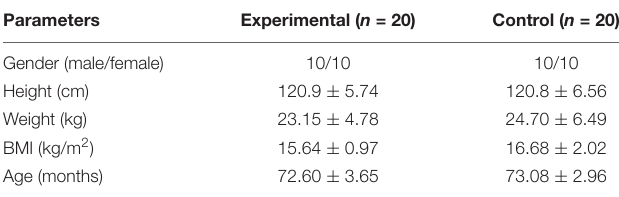
TABLE 1 | Characteristics of